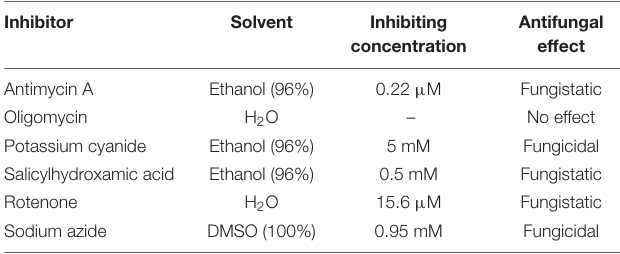
The table represents the minimal inhibiting concentration and whether the inhibitors show fungicidal or fungistatic effect.